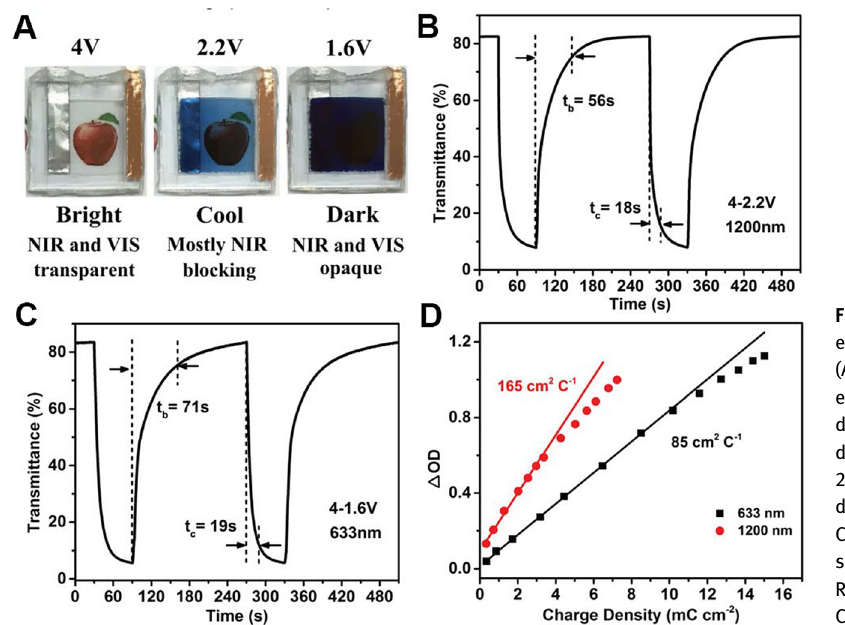
Figure 7: Al anode – based electrochromic energy storage